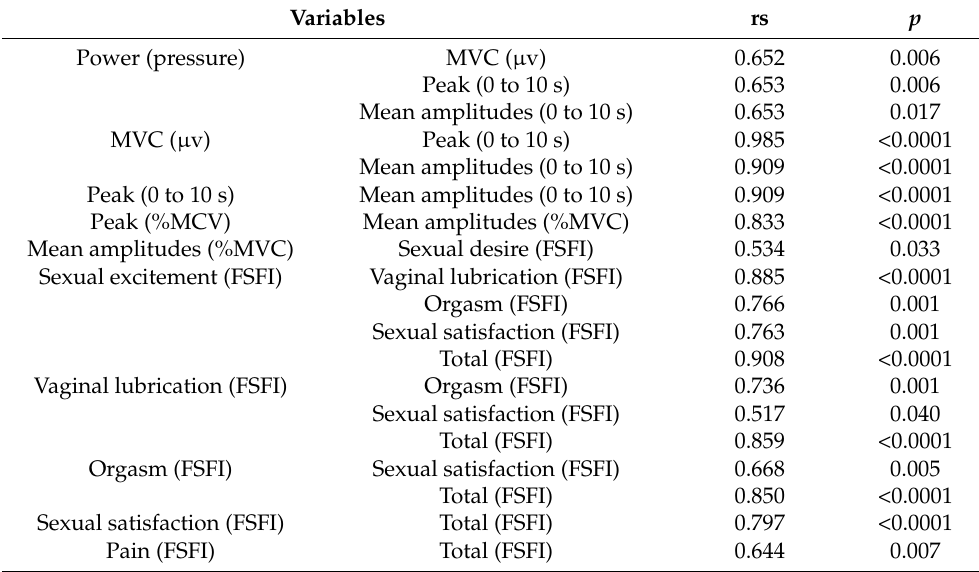
Table 2. Correlation among the control group variables